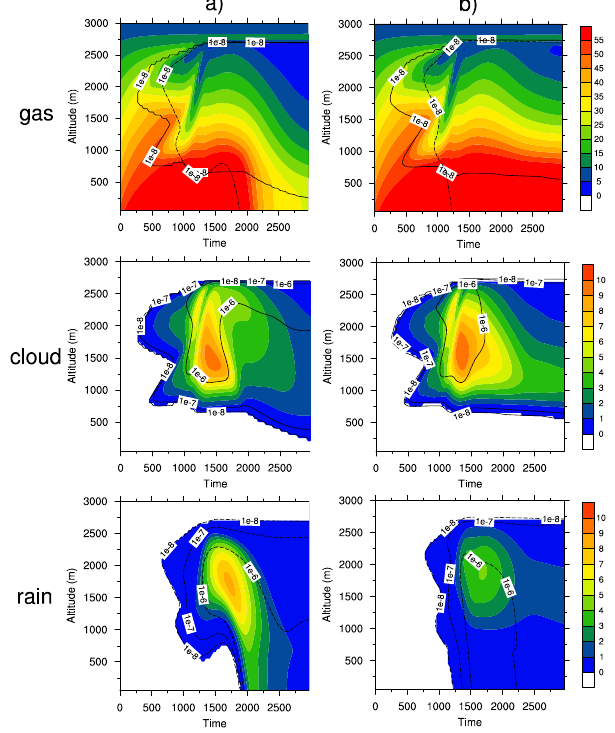
Figure 3. HaRP case: same as Figure 2 but for sulphur dioxide (pptv). 4 Fig. 3. HaRP case – same as Fig. 2 but for sulphur dioxide (pptv).